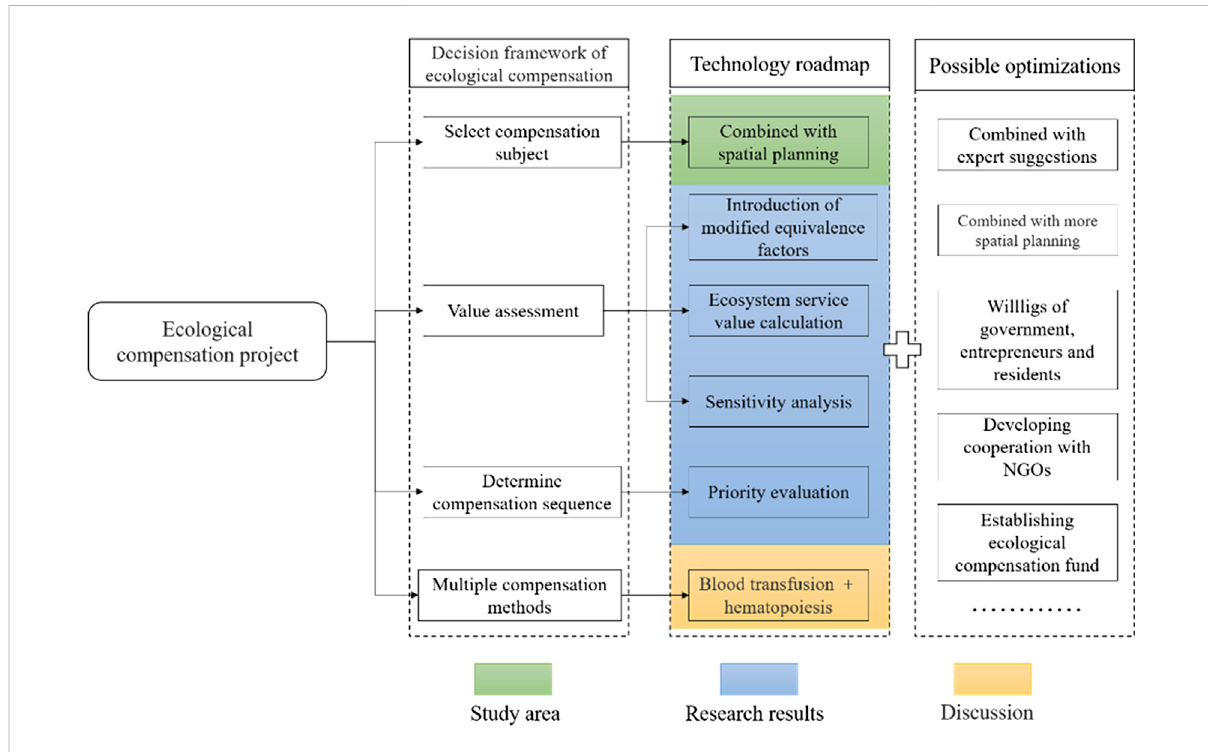
FIGURE 1 Decision framework of